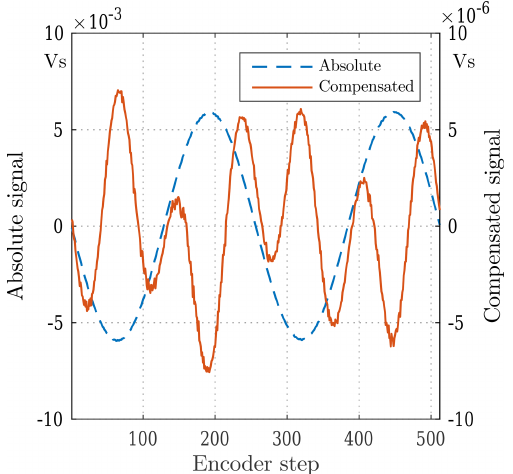
Figure 9. The acquired integrated voltage between steps of the en- coder over one rotation.